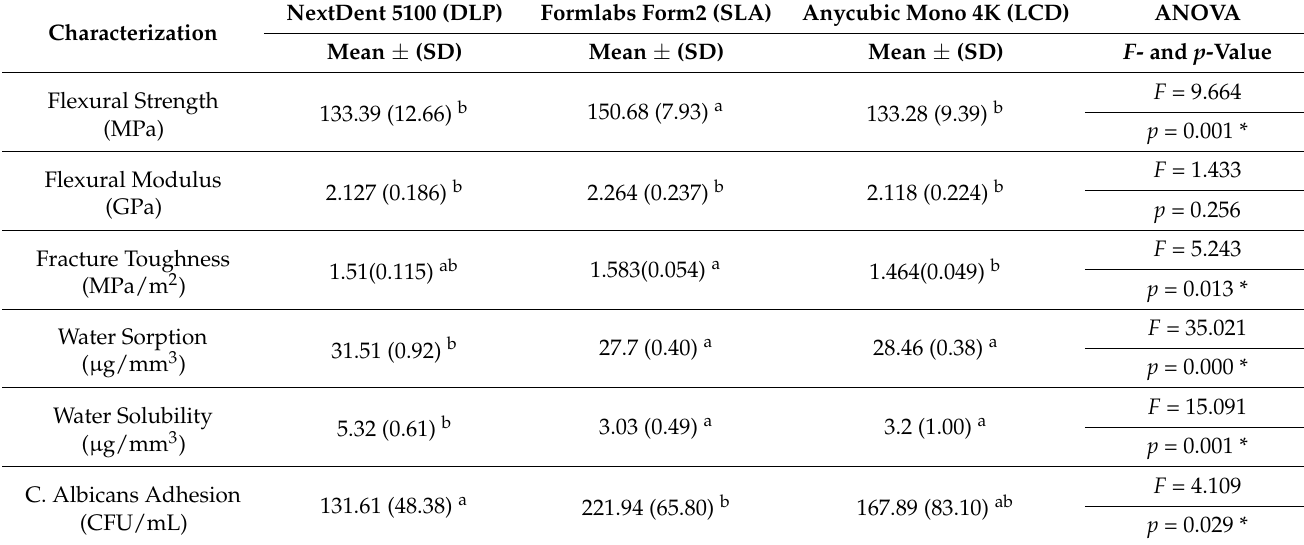
Table 4. Flexural strength ( σ ), flexural modulus (E), fracture toughness ( K max ), water sorption ( w sp ), water solubility ( w sl ), and C. Albicans adhesion ( C ) results of 3D-printed denture base printed with different vat polymerization techniques.